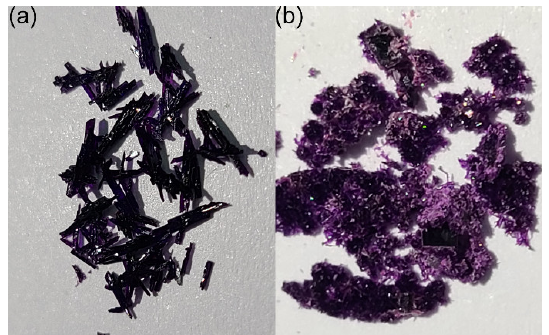
Figure 1. Macroscopic views of crystals of [CrCl 2 (μ-Cl)(thf) 2 ] 2 ( a ) and irregular solid known as CrCl 3 (thf) 3 ( b ).